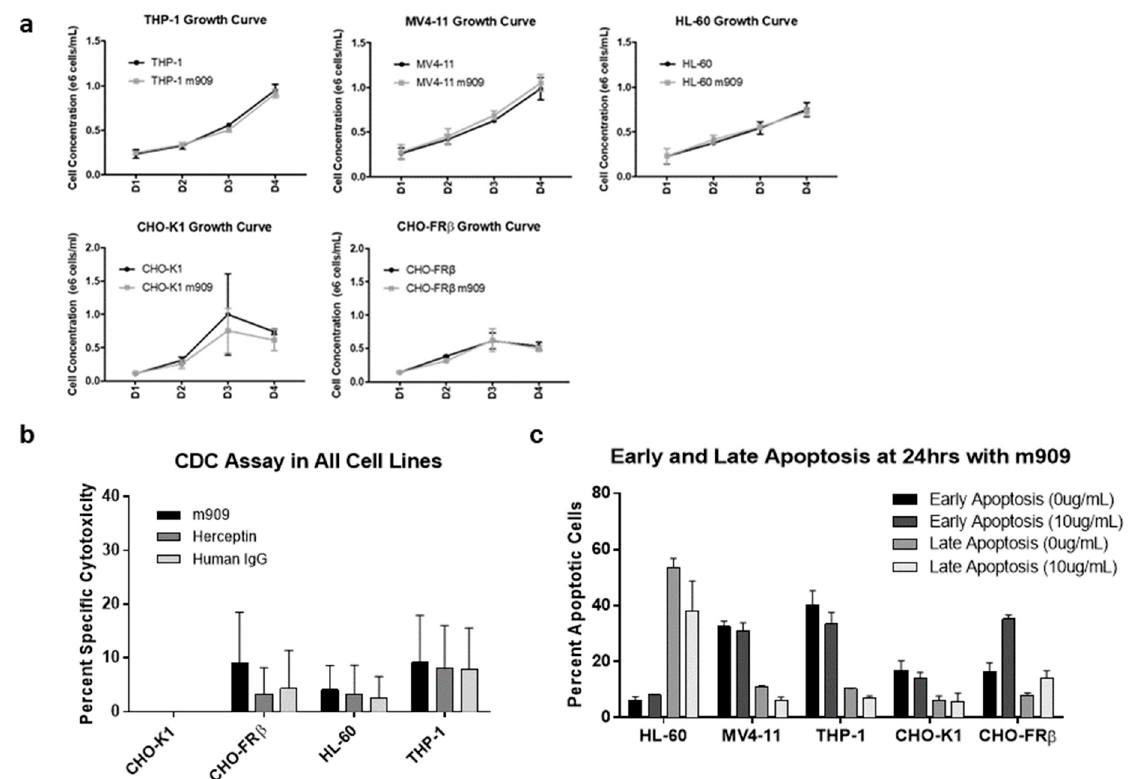
Figure 2. Evaluating additional mechanisms of action for m909 antibody. ( a ) Cells grown in the presence or absence of 10 µ g/mL of m909 over time in days. ( b ) Complement-dependent specific cytotoxicity for cell lines in presence of 10 µ g/mL of m909, Herceptin, or human IgG1 with human serum. Samples tested in triplicate. ( c ) Percentage of cells with early and late markers of apoptosis after 24 h of incubation with and without 10 µ g/mL m909. All error bars represent standard deviation.